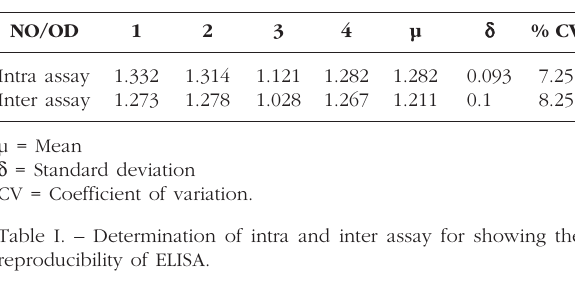
Sensitivity and specificity of ELISA The sensitivity and specificity of ELISA on comparison with IFAT were 95.5 % and 66.6 % respectively.